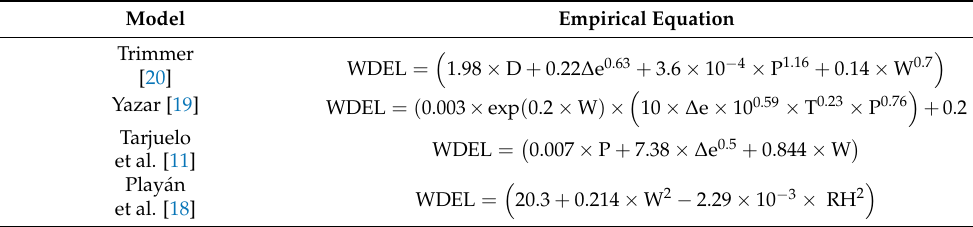
Table 2. The investigated previous mathematical empirical models to estimate